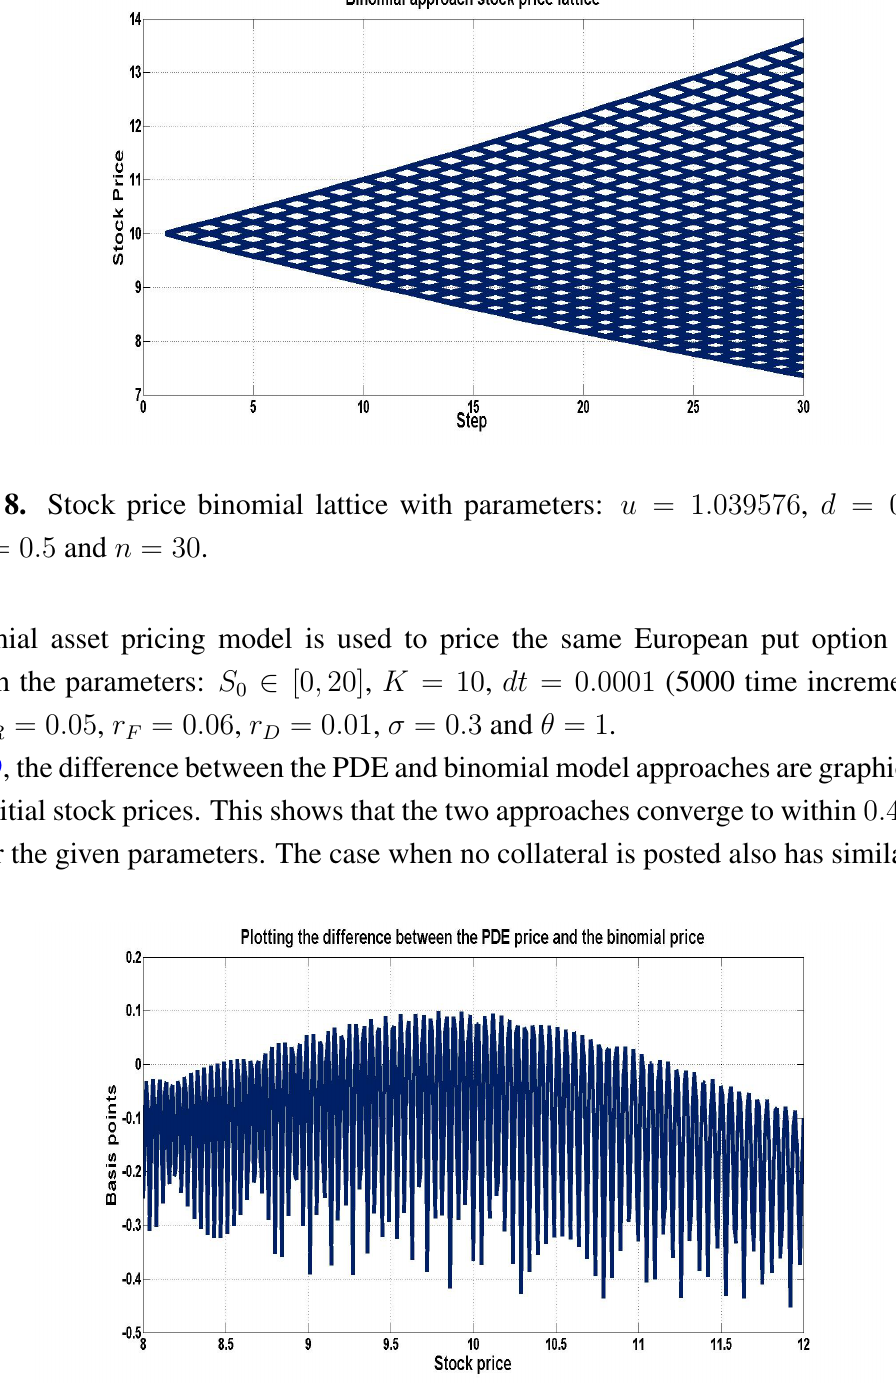
∈ [8 , 12] , K = 10 , dt = 0 . 0001 (5000 time 0 = 0 . 04 , r = 0 . 05 , r = 0 . 06 , C R F